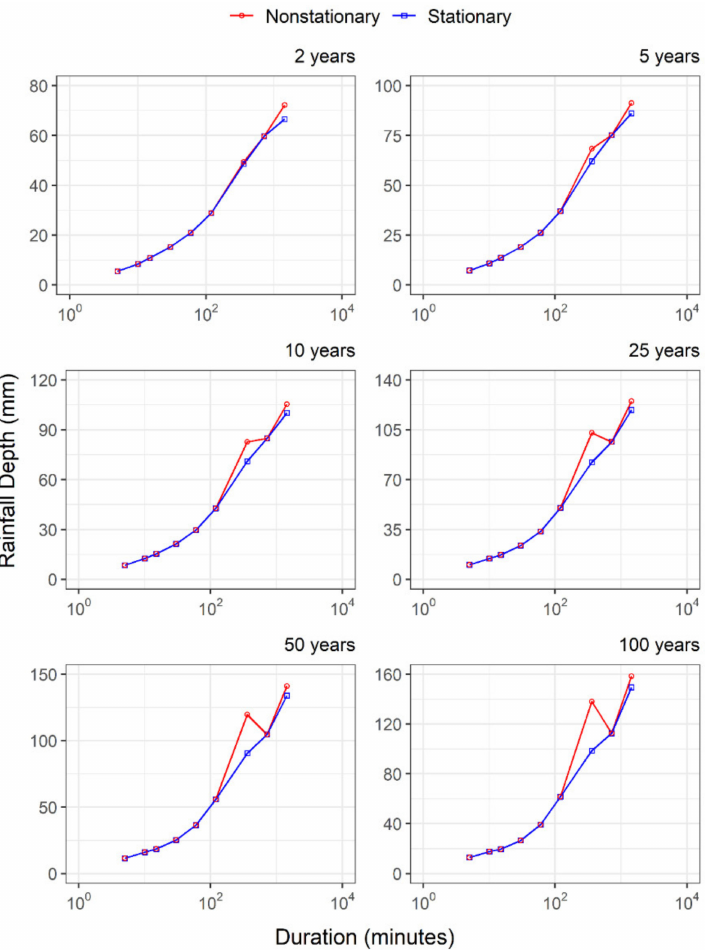
Figure 4. Stationary and non-stationary rainfall depths for different return periods for Shearwater